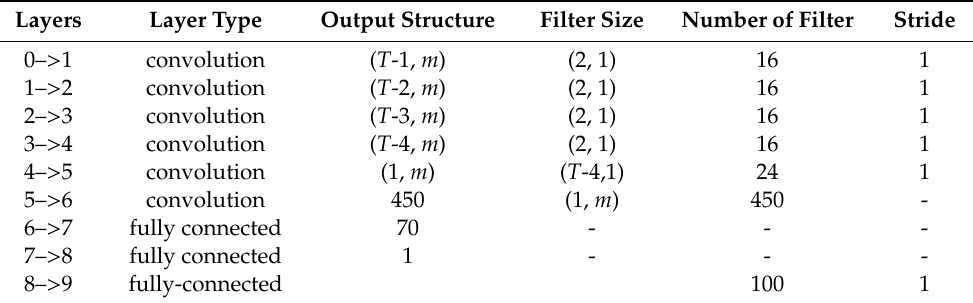
Table 5. The architecture of CNN with daily input data.